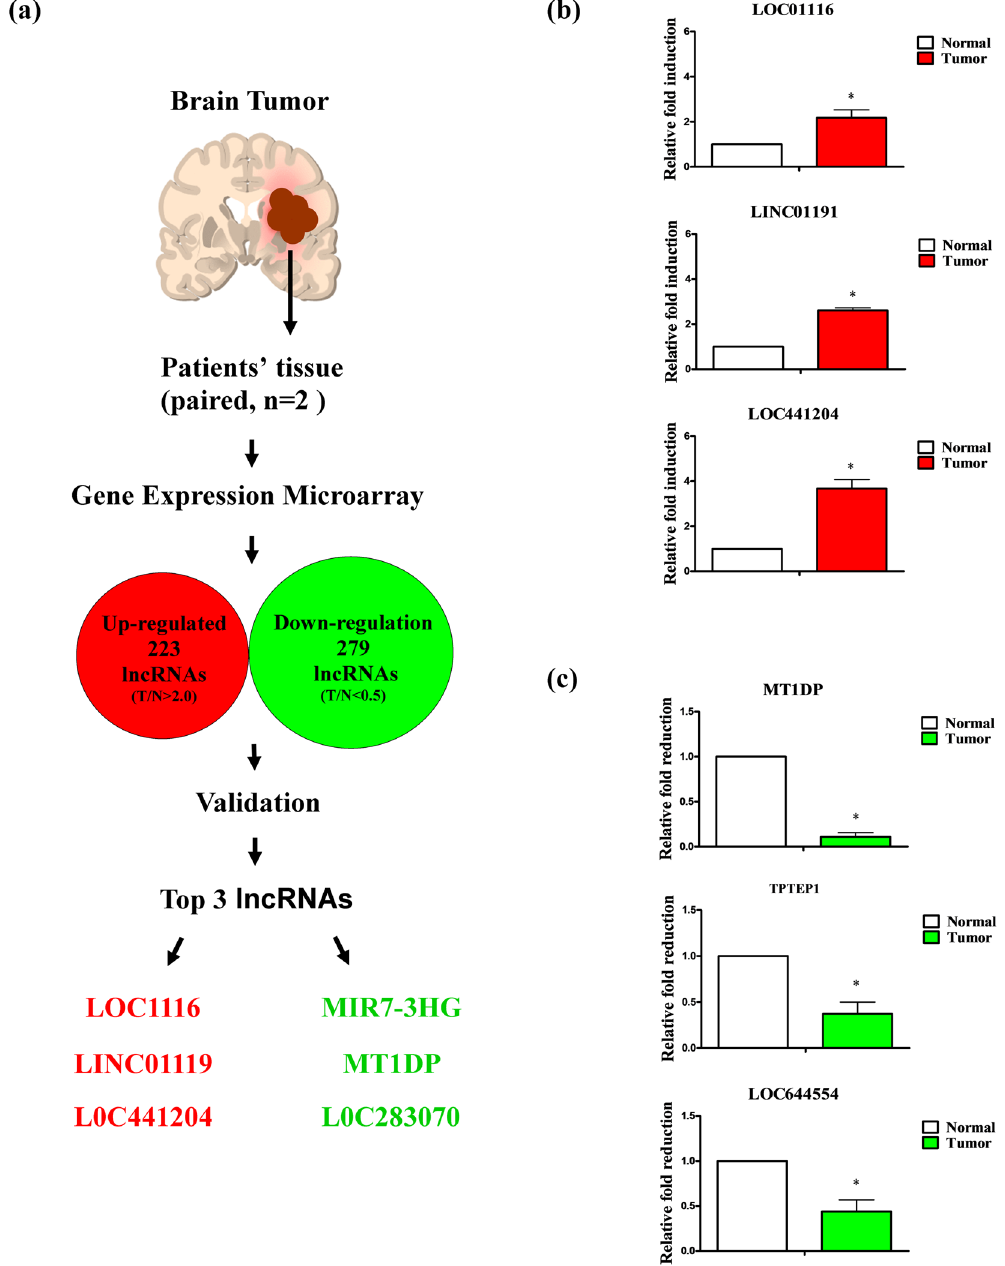
Figure 1. Analysis and validation of lncRNAs in brain tumor specimens. ( a ) Schematic diagram showing application of gene expression microarrays to lncRNA analysis. ( b ) Upregulation and ( c ) downregulation of lncRNAs in brain tumor specimens measured using q-RT-PCR. Differences were analyzed using Kruskal-Wallis test ( * P <